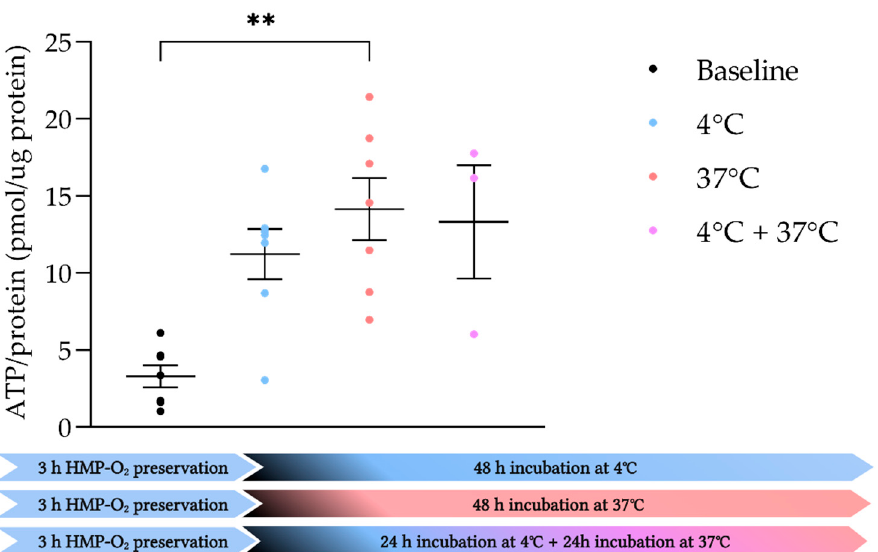
Figure 5. Incubation of slices at different temperatures. ATP/protein levels of porcine kidneys that were preserved with oxygenated HMP sliced at baseline ( • ) ( n = 7) and incubated for 48 h in WME at 4 ◦ C ( • ) ( n = 7), 37 ◦ C ( • ) ( n = 7), or first 24 h at 4 ◦ C and then rewarmed to 37 ◦ C for 24 h ( • ) ( n = 3). ** p < 0.01. ATP, adenosine triphosphate. The data are shown as mean ± SEM.